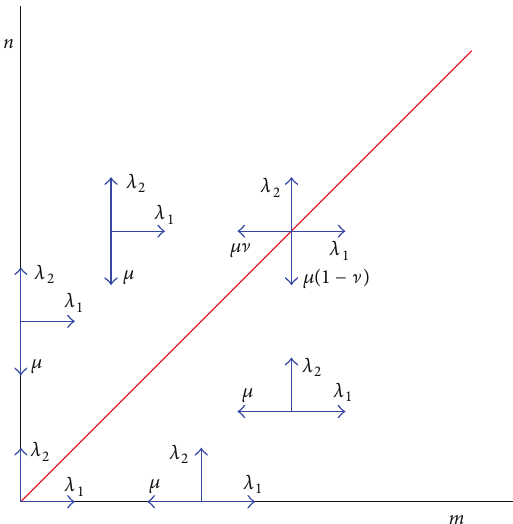
Figure 1: A sketch of the transition rates for the random